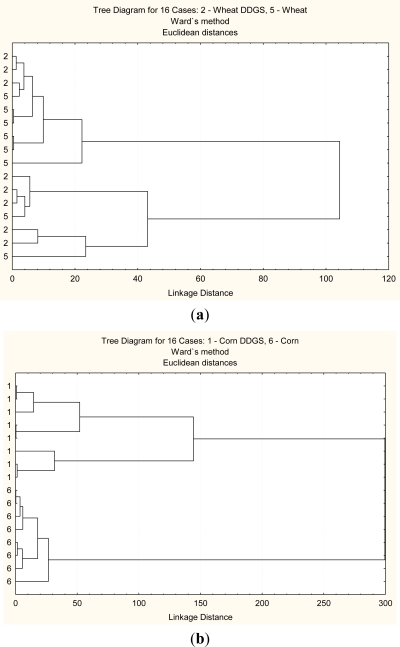
Multivariate molecular spectral analyses of the co-products from bioethanol production at the hemi-and cellulosic compounds region (ca. 1452–1188 cm−1): CLA cluster analyses of molecular spectrum (Distance method: Euclidean; Cluster method: Ward’s algorithm); Principal component analyses (PCA) of molecular mid-IR spectrum. (a,c) wheat DDGS (code 2) vs. wheat (code 5); (b,d) corn DDGS (code 1) vs. corn (code 6). (a) Cluster analysis: molecular structure of wheat vs. molecular structure of wheat DDGS; (b) Cluster analysis: molecular structure of corn vs. molecular structure of corn DDGS; (c) PCA: molecular structure of wheat vs. molecular structure of wheat DDGS. 1st vs. 2nd principal component; (d) PCA: molecular structure of corn vs. molecular structure of corn DDGS. 1st vs. 2nd principal component.